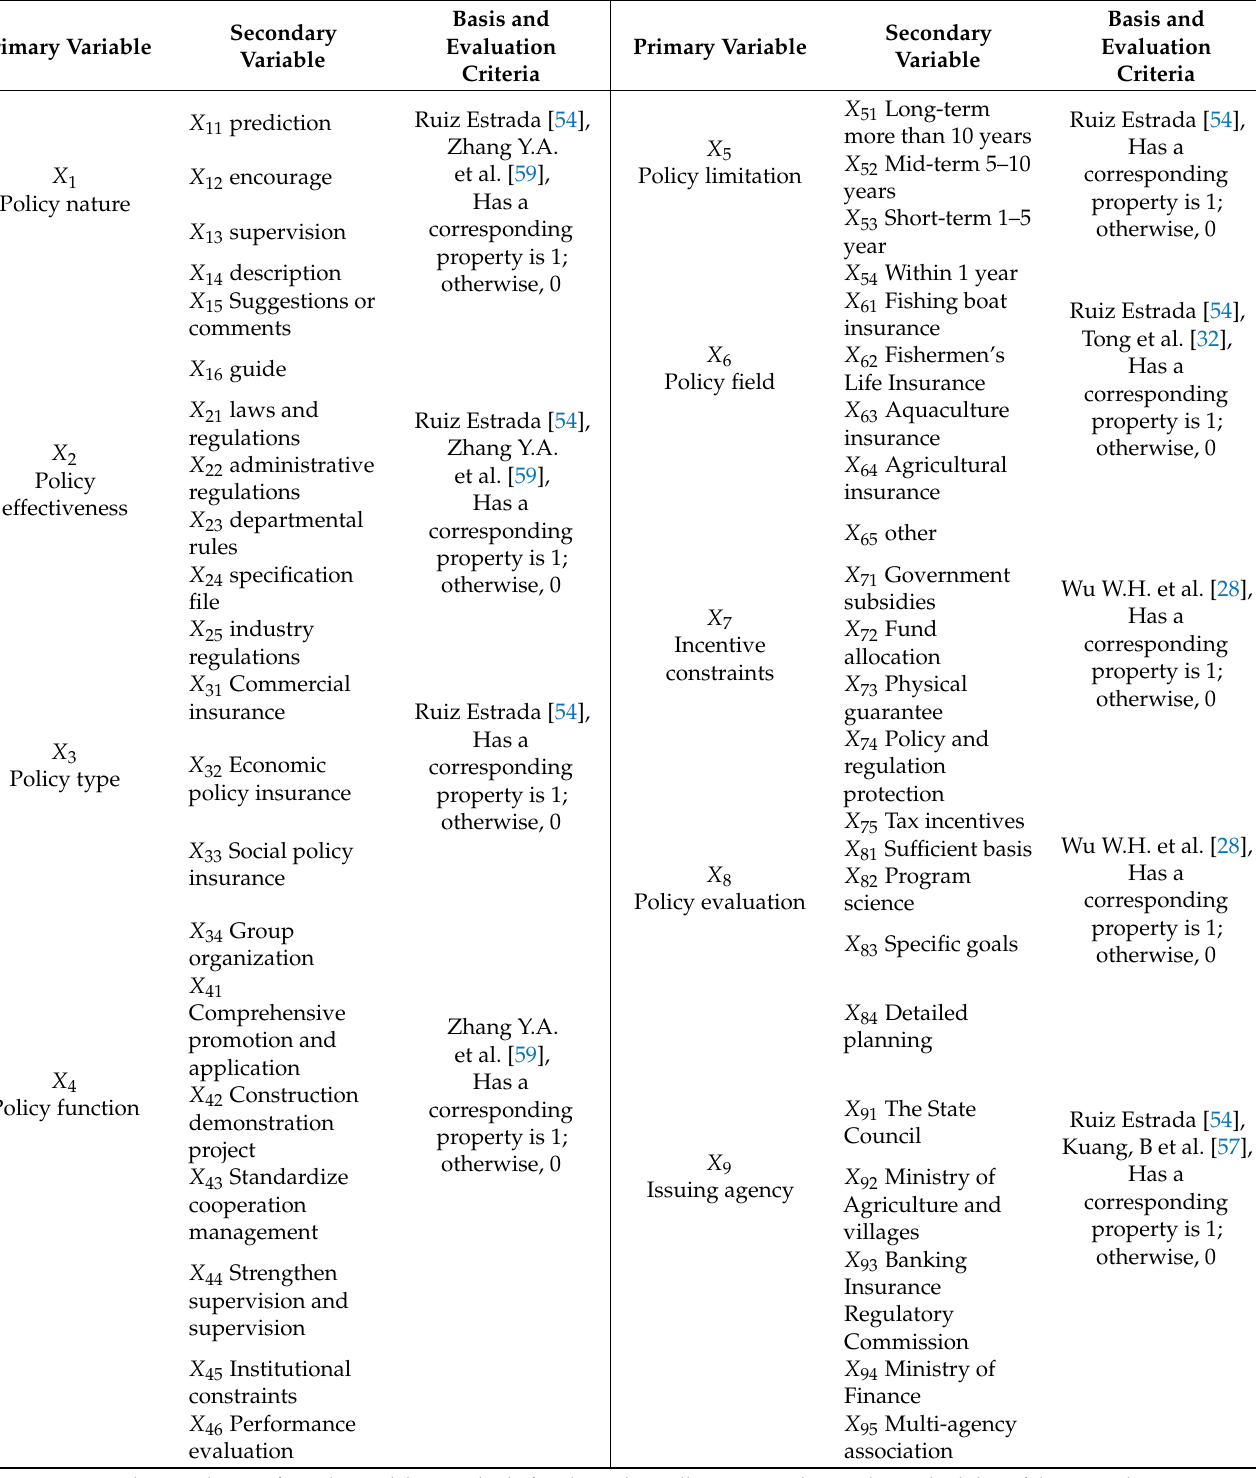
Table 1. Evaluation index system of fishery insurance